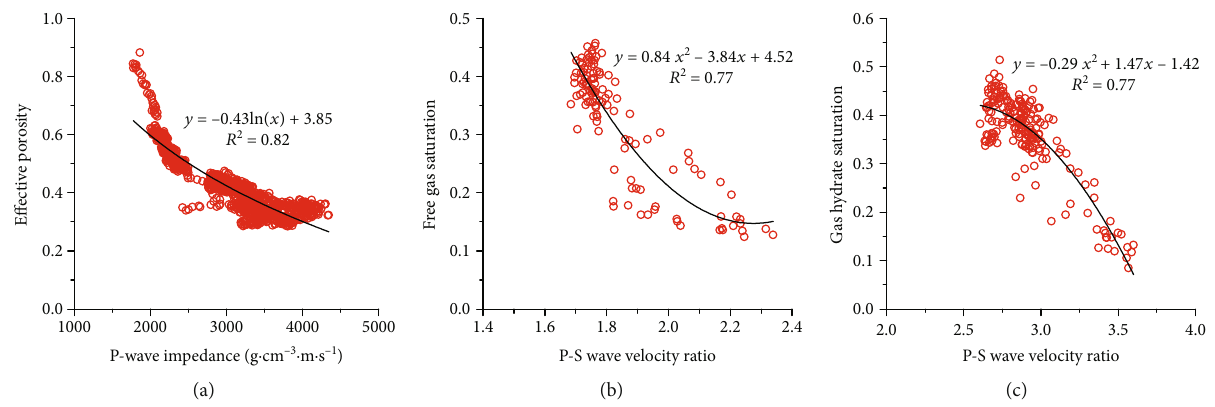
Figure 4: Correlation plate of physical properties and elastic parameters for gas hydrate and free gas.